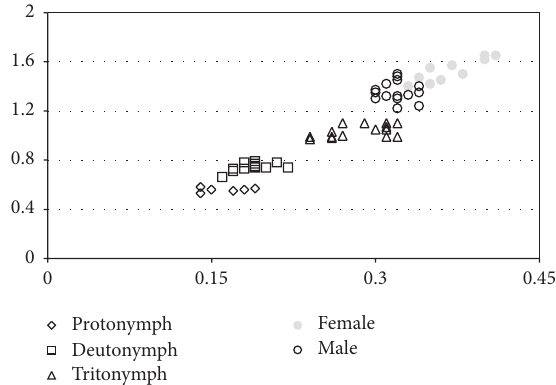
Figure 1: Chelal growth of all postlarval stages of Dactylochelifer gracilis